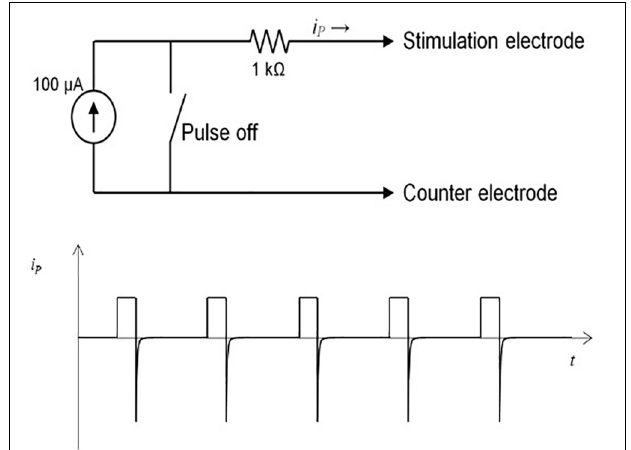
FIGURE 2 | (A) Operational principle with 100 µ A power and reed switch. (B) Monophasic pulses in current over time diagram. After end of pulse current dissipates in the tissue so net charge is zero.